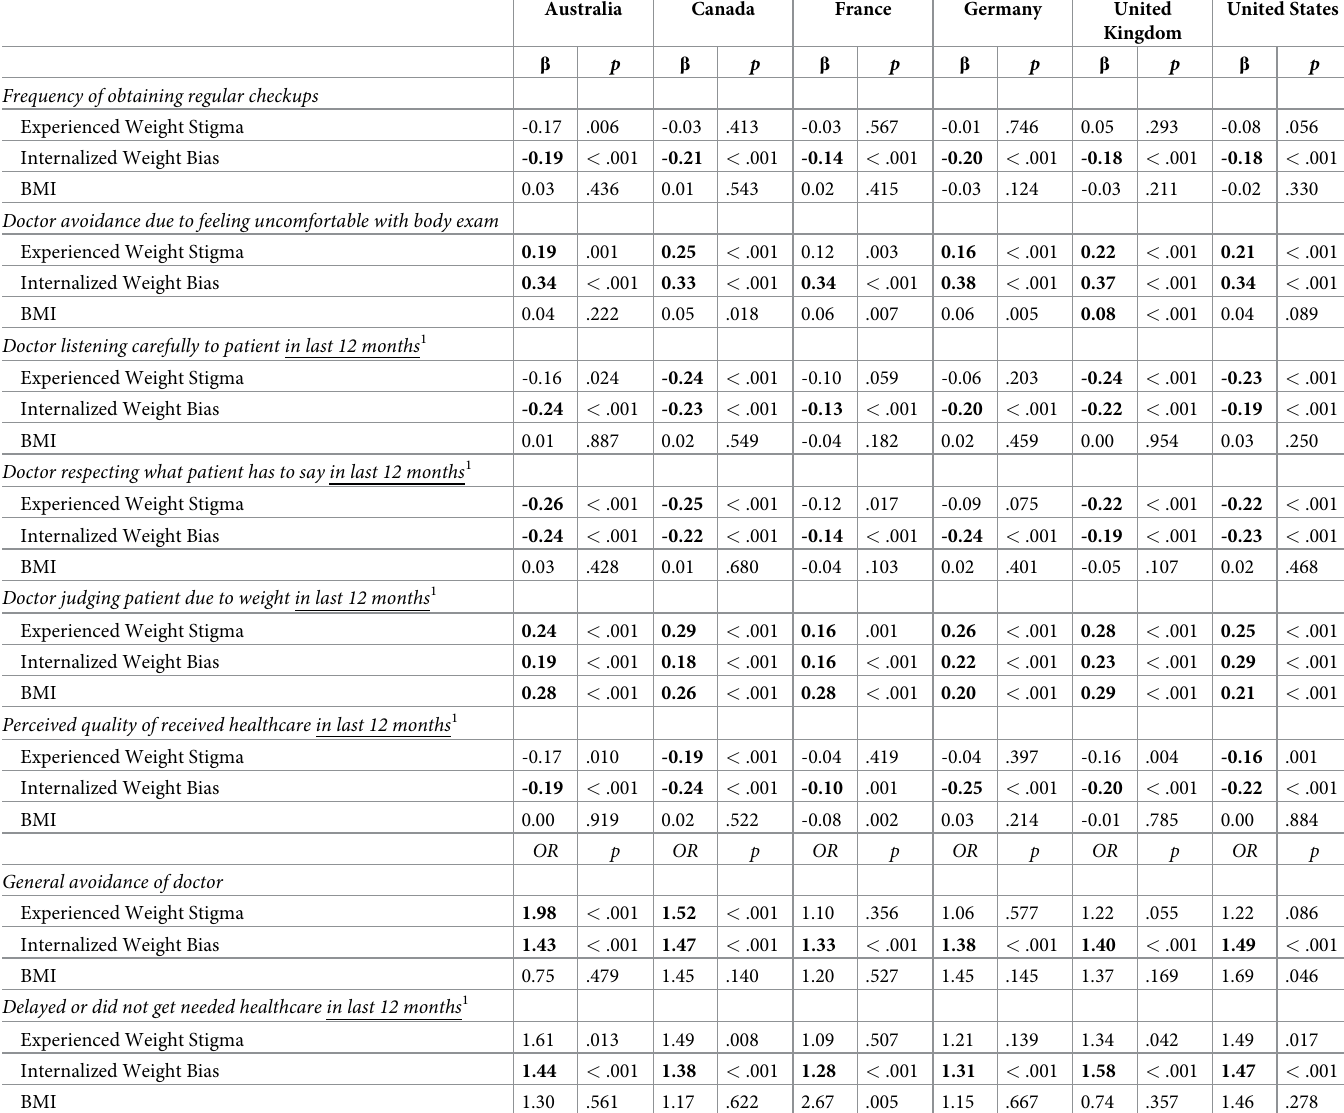
Table 3. Associations between weight stigma (experienced and internalized) and healthcare experience